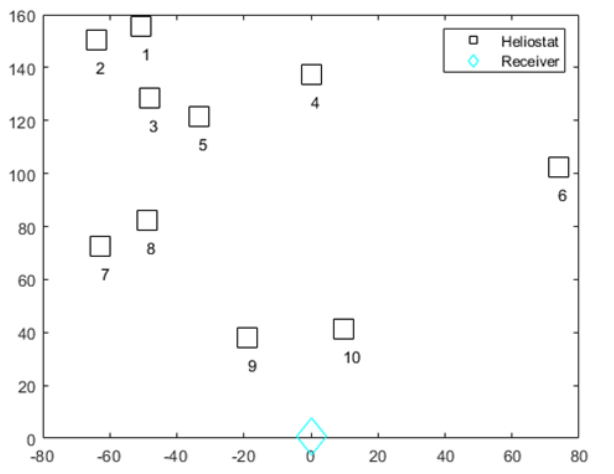
Figure 6. Distribution of ten heliostats and